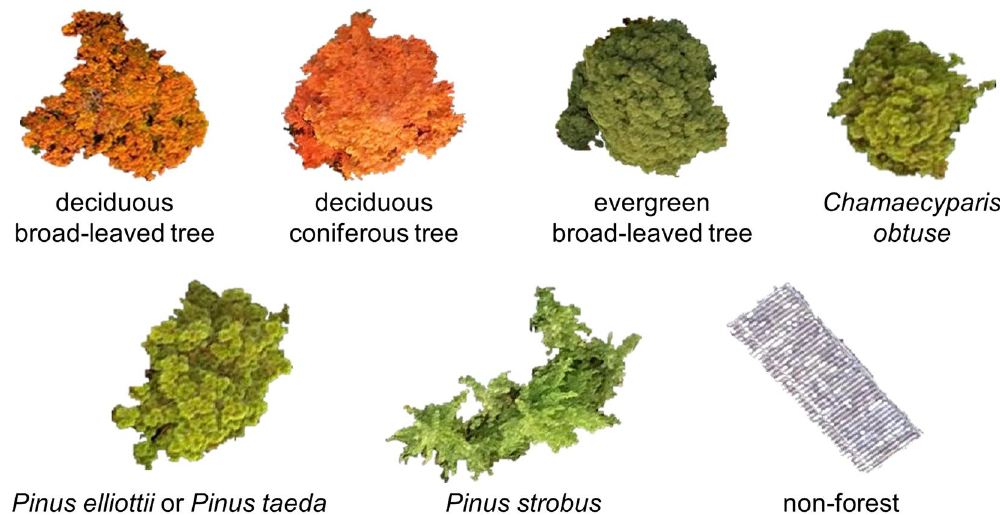
Figure 4. Representative extracted images from each class in the November 20 images. These images were segmented well at each tree crown level. However, the image of Pinus strobus includes several tree images. The image of the non-forest class shows the roof of a house.